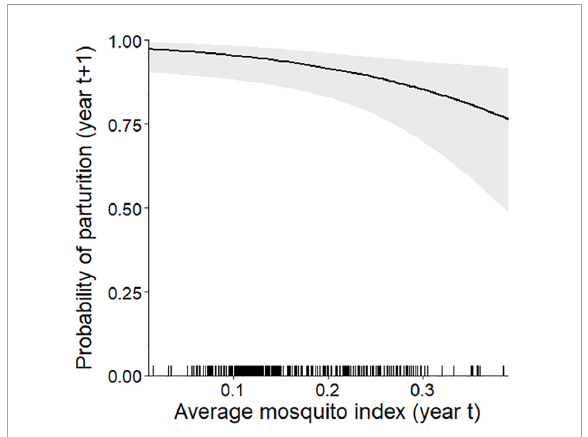
FIGURE3 Individual-level probability (and 95% confidence interval) of an adult female caribou being parturient in year t + 1 modeled as a function of the average mosquito index during the mosquito harassment season the previous summer (year t ), Central Arctic Herd, Alaska, 2003–2020. The rug plot along the bottom of the figure depicts the distribution of